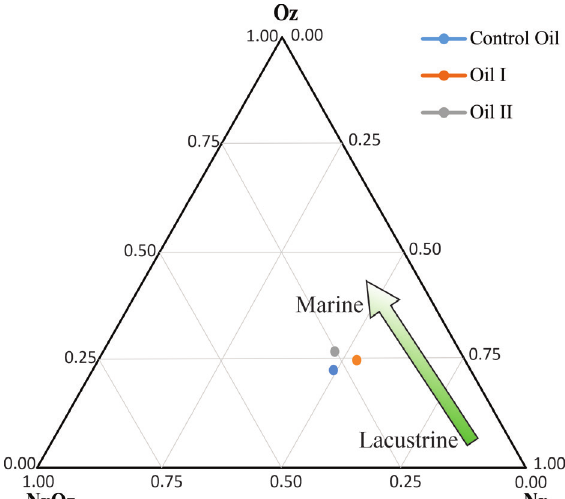
Figure 10. Ternary diagram for the most abundant elemental classes assigned on the negative ESI FTICR- MS results: Nx, Oz, and NxOz, for the oil samples (I, II, and Control